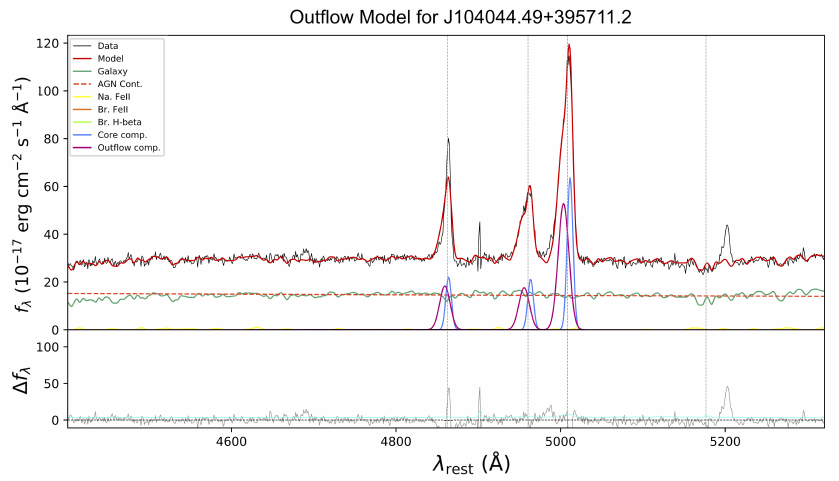
Figure 3. An example of H β +[O III ] λλ 4959,5007Å region fitted by BADASS. The spectrum and the overall best-fit model are presented in black and red, respectively. The individual fitting components are designated by different colors.